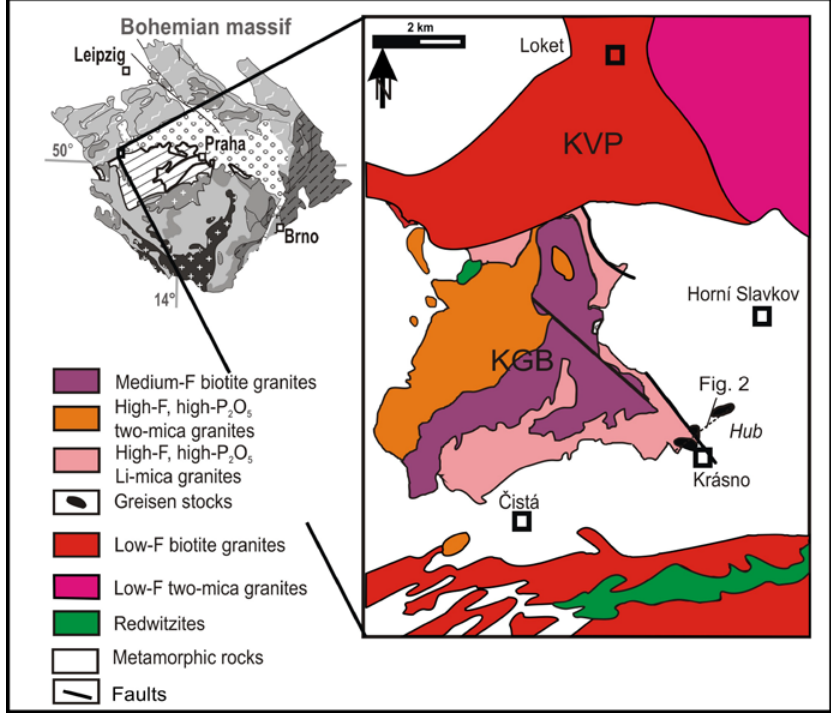
Figure 1. Schematic geological map of the Krudum granite body modified after [17].